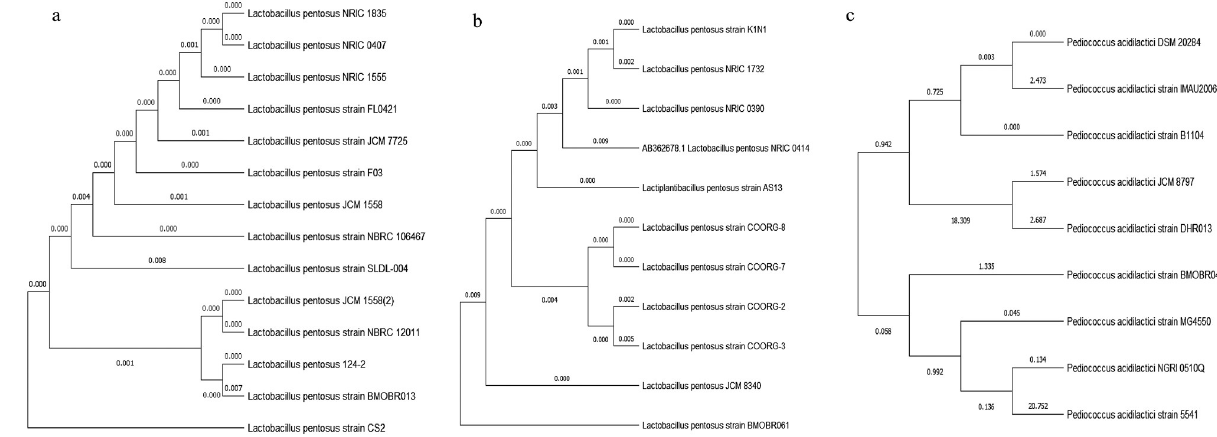
Fig 1. Phylogenetic analysis of the LAB isolates based on 16S rRNA gene sequence a) Lactobacillus pentosus BMOBRO13, b) Lactobacillus pentosus BMOBRO61 and c) Pediococcus acidilactici BMOBRO41. The dendrogram was constructed based on the BLAST algorithm and maximum likelihood method using MEGA X software with 1000 bootstrap